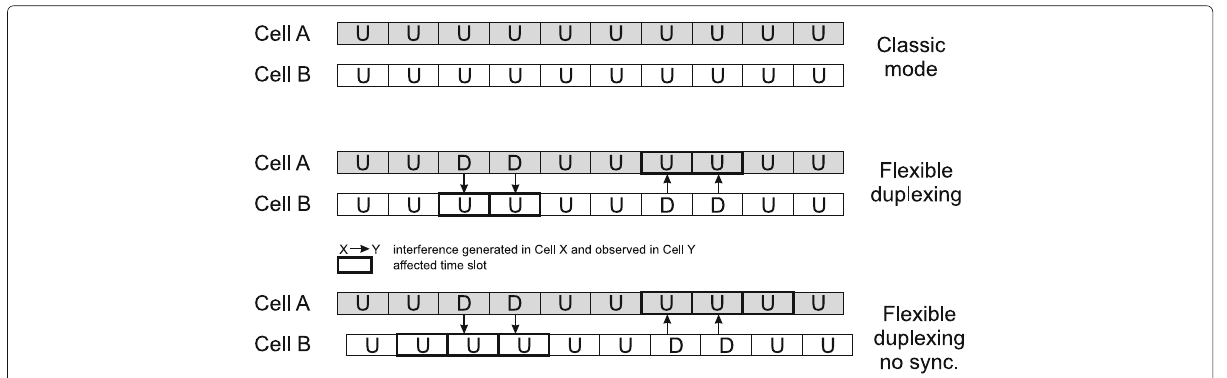
Fig. 1 Examples of flexible duplexing schemes in TDD mode